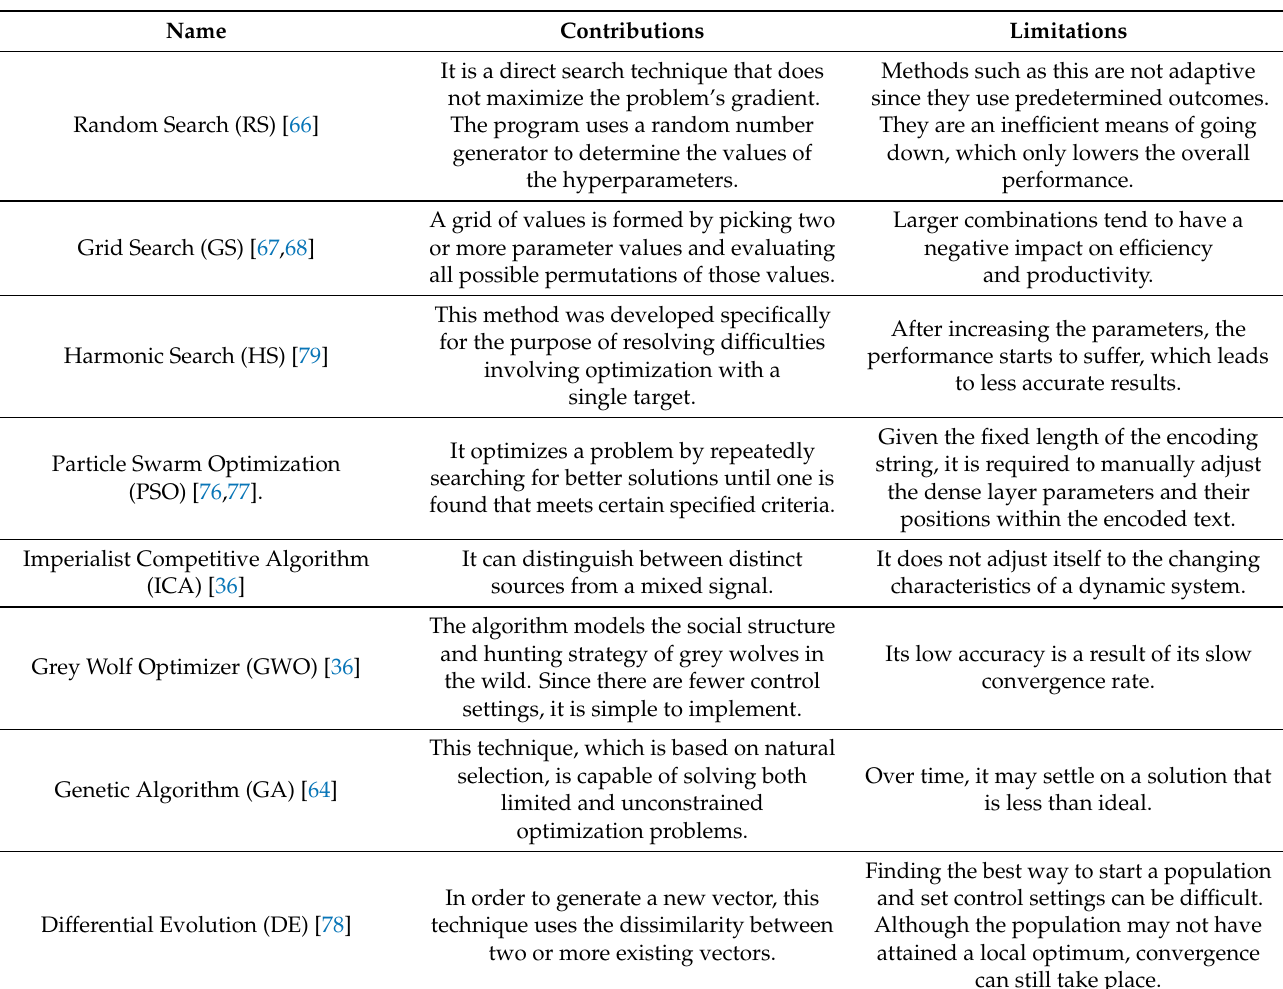
Table 1. Summary of metaheuristic optimization techniques in the